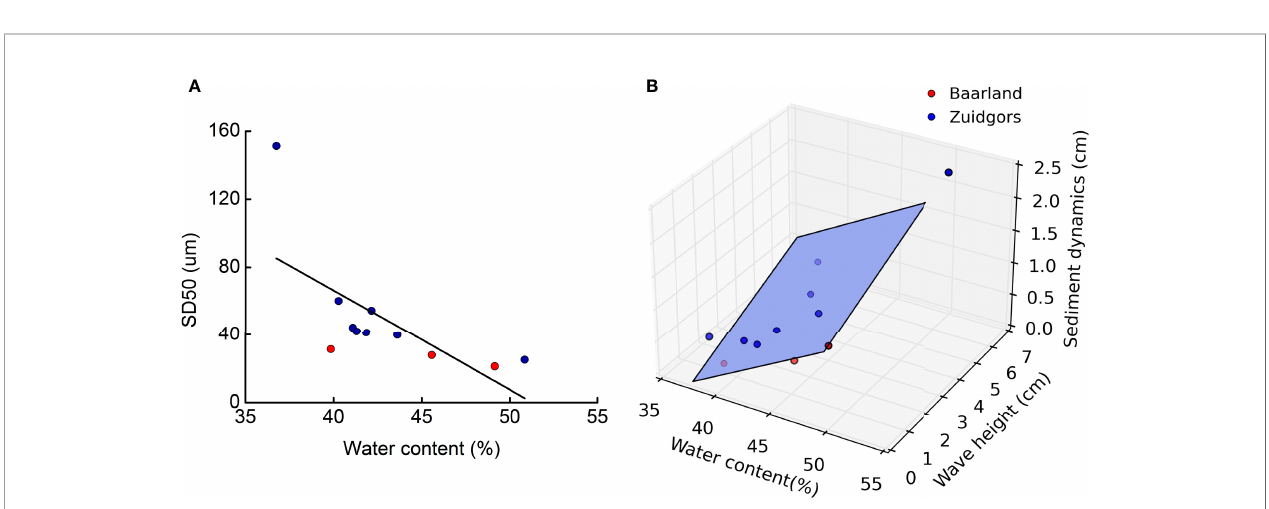
FIGURE 5 | Field measurements in Baarland and Zuidgors showing (A) sediment water content was positively correlated to sediment grain size (R 2 = 0.40, p <0.01), and (B) sediment dynamics depends on a combination of sediment water content and wave height (R 2 = 0.47, p <0.05).